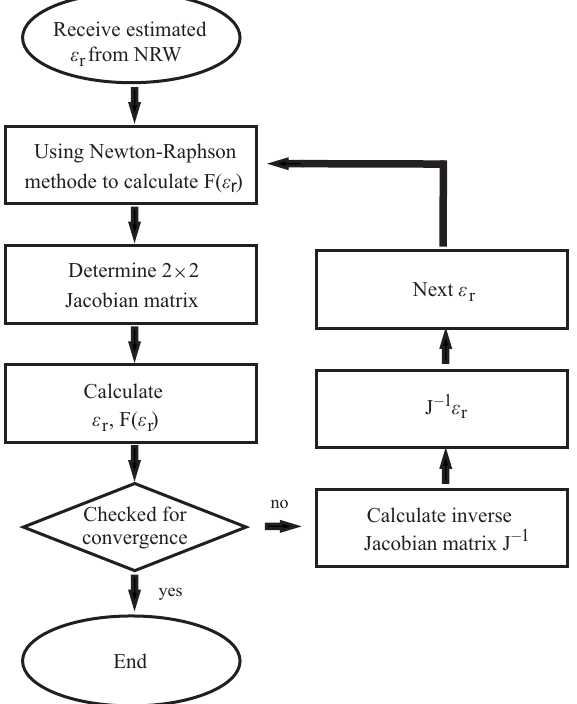
Figure 10. Flow chart of the NIST